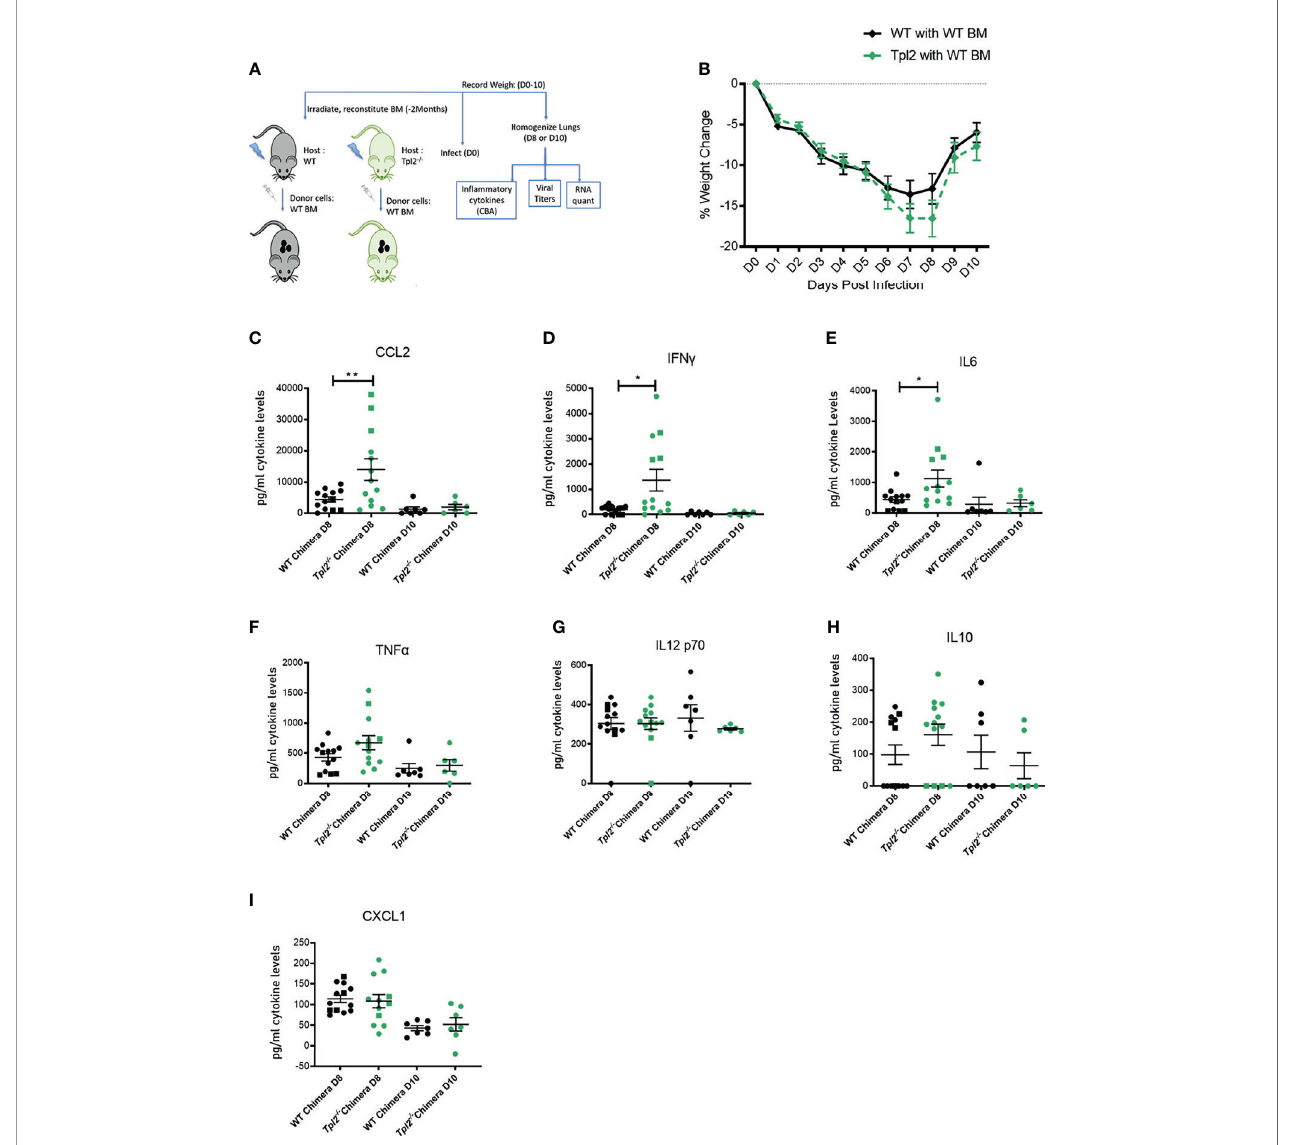
FIGURE 6 | Tpl2 ablation in the radioresistant cells allows for an initial cytokine burst at 8 dpi, but chimeras recover by 10 dpi. (A) Experimental outline for infection of chimeras. WT or Tpl2 -/- mice were irradiated and given WT bone marrow to reconstitute for 2 months. They were then infected and studied for 8-10 days for clinical outcome and cytokine examination on day 8 or day 10 post infection. (B) Weight loss curve shows that the Tpl2 -/- chimeras show greater weight loss by day 8, but are able to recover their weights by day 10 post infection. Diamonds represent that the data points are averaged for males and females. (C – I) Cytokine expression at day 8 or day 10 post infection. Unpaired student ’ s t-test *p<0.05,